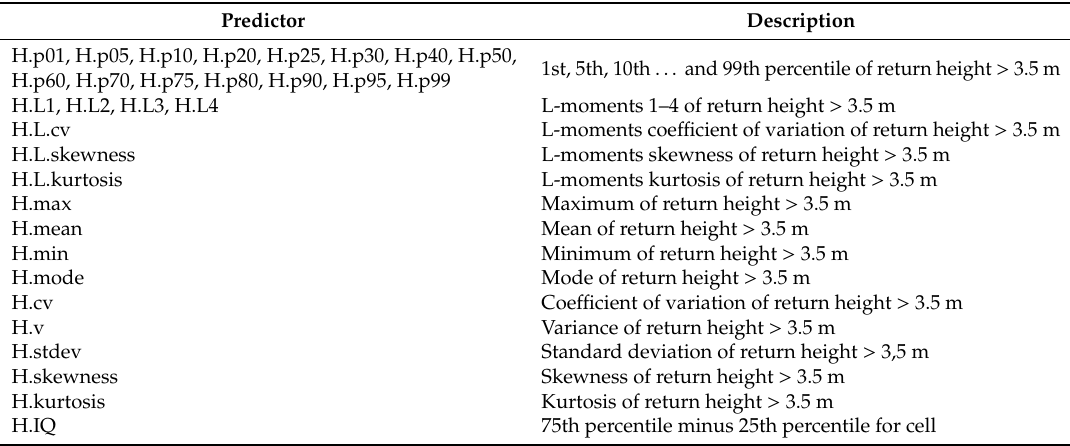
Table A1. Summary of airborne laser scanning metrics computed using Fusion [62,63]. Predictor